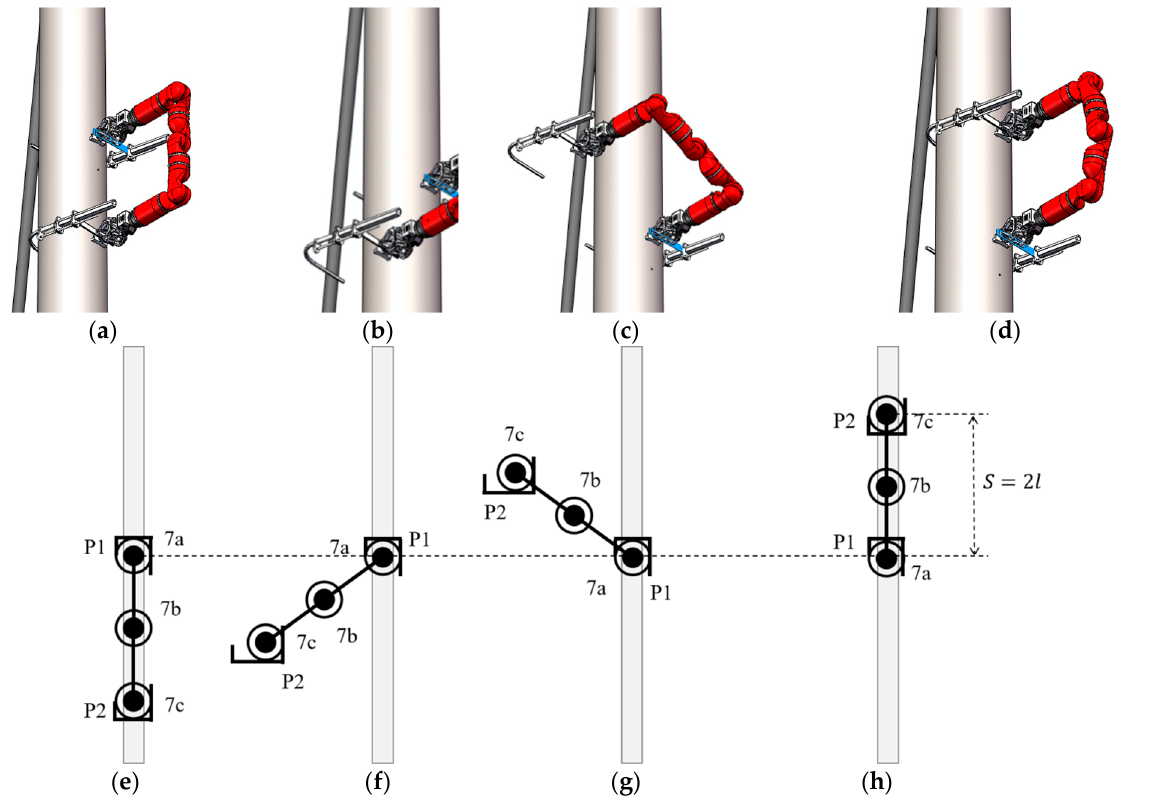
Figure 12. Turning-around gait. ( a ) Initial state, ( b ) motion 1, ( c ) motion 2, ( d ) completed state, ( e ) side elevation of initial motion, ( f ) side elevation of motion 1, ( g ) side elevation of motion 2, ( h ) side elevation of completed